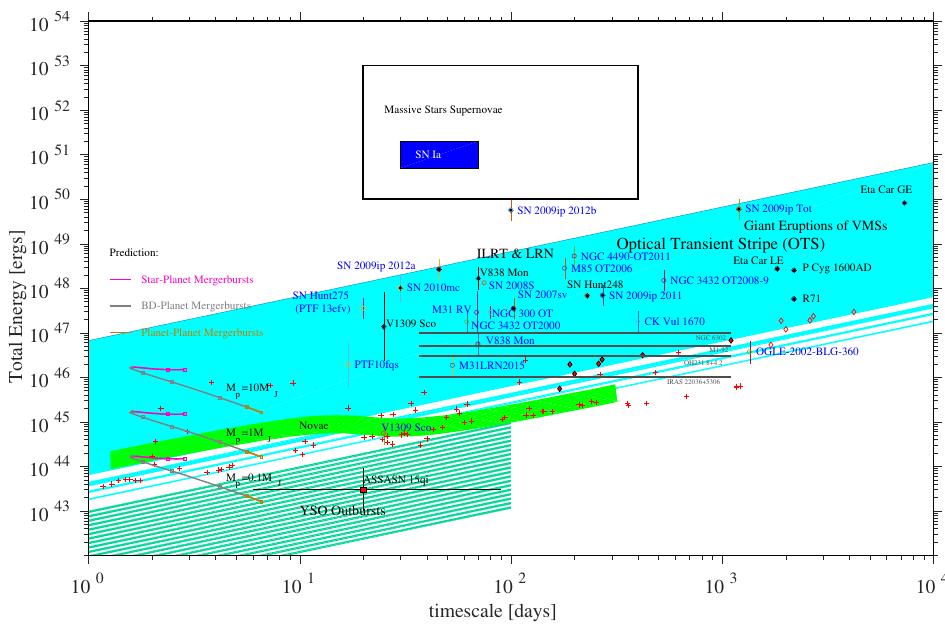
Figure 1. Intermediate luminosity optical transients (ILOTs) on the energy-time diagram (ETD). The abscissa represents the eruption timescale, usually the time for ∆ V = − 3 mag. The ordinate represents the eruption energy. The blue empty circles represent the total (radiated + kinetic) energy. The black asterisk represents the total available energy (modeled value for some ILOTs). The optical transient stripe is populated by ILOT events powered by gravitational energy or complete merger events or vigorous mass transfer events. Novae models are marked with a green line [1] with red crosses [2] or with diamonds [3]. The four horizontal lines show Planetary Nebulae (PNe) and Proto Planetary Nebulae (PPNe). that might have been formed by ILOT events [4]. Merger models of a planet with a planet or a brown dwarf (BD) star [5] are presented on the left, along with models we added for smaller merging planet with a mass of 0.1 M J . The lower-left part (hatched in green) is our extension for younger objects [6], including ASASSN-15qi (red square), where the planets are of lower density and can more easily undergo tidal